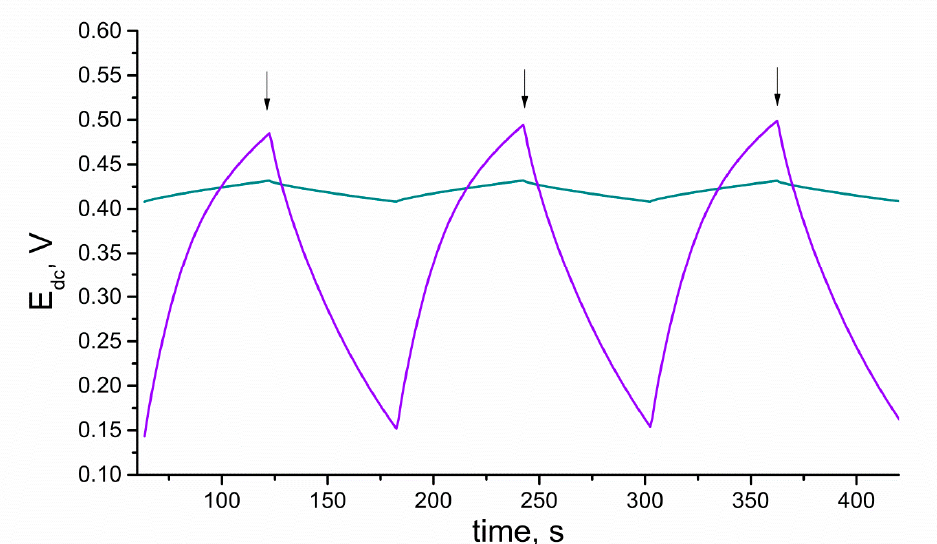
Figure 7. Comparison of electrochemical properties of anhydrous (violet) and hydrous (blue) RuO 2 tested with the use of chronopotentiometry. Arrows point the moment of the current sign change.